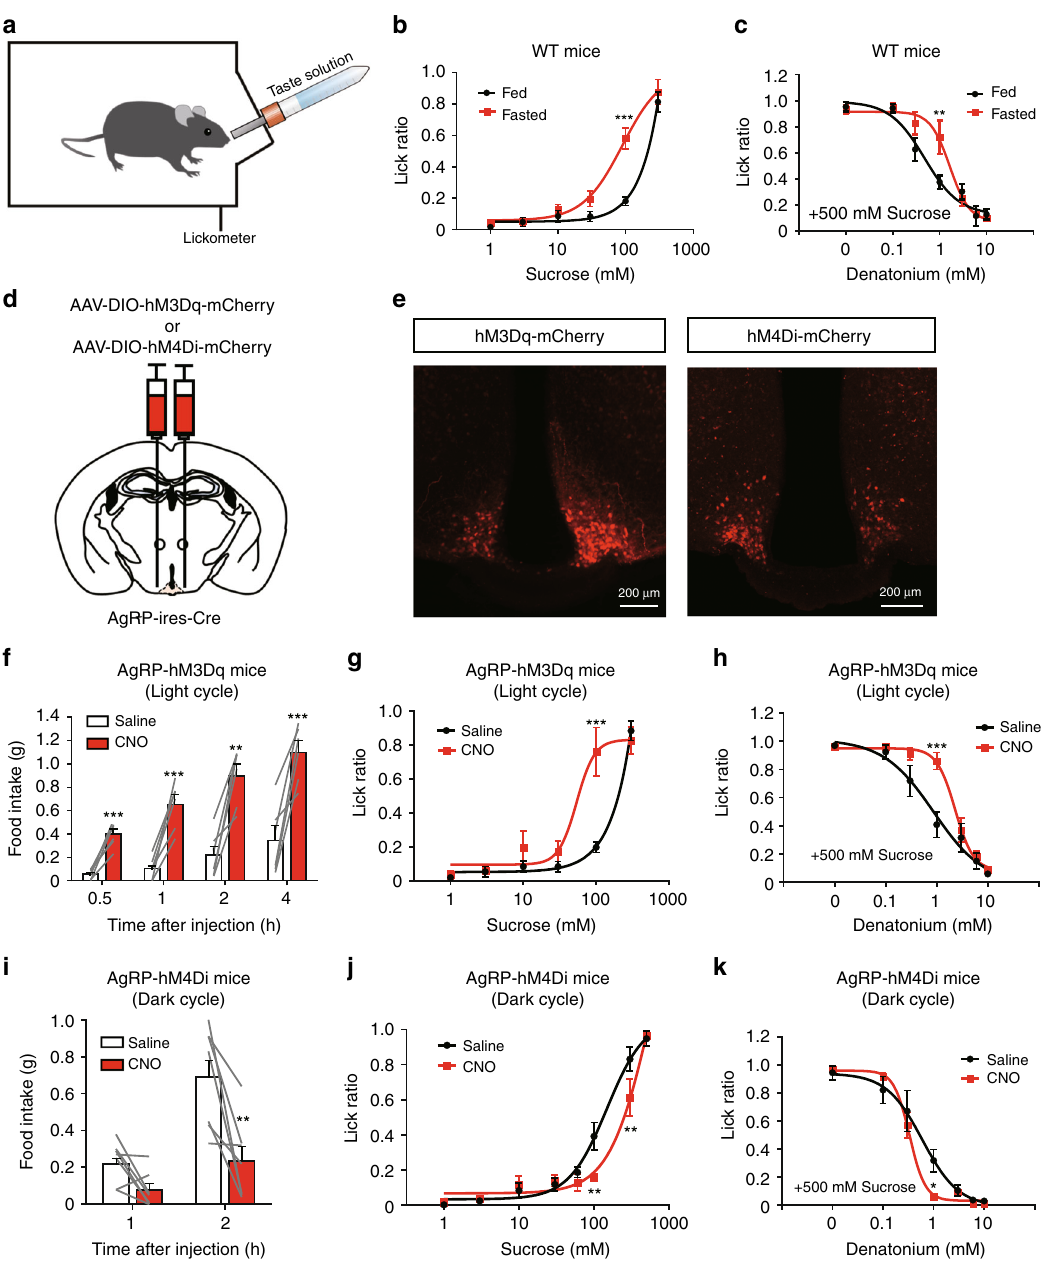
Fig. 1 Chemogenetic activation of AgRP neurons induces changes in taste preference. a Schematic image of the brief access taste test. The number of licks is measured during 10 s from the fi rst lick. b , c Sweet ( b ) or bitter ( c ) taste preferences in fed or fasted mice. Sucrose or denatonium – sucrose solutions were presented to fed or 23-h-fasted C57BL/6J WT mice. n = 6, F = 17.81, and P = 9.4 × 10 – 5 in b and n = 6, F = 4.14, and P = 0.045 in c , two-way ANOVA with Bonferroni post hoc test. d Bilateral injection of AAV encoding Cre-dependent hM3Dq-mCherry or hM4Di-mCherry into the arcuate nucleus (ARC) of AgRP-ires-Cre mouse. e Representative image showing hM3Dq-mCherry-expressing AgRP neurons (left) in the AgRP-hM3Dq mouse and hM4Di- mCherry-expressing AgRP neurons (right) in the AgRP-hM4Di mouse. f Chemogenetic activation of AgRP neurons led to acute food intake in AgRP- hM3Dq mice during the light period. n = 6, paired Student ’ s t test. g , h Brief access taste tests for sweet ( g ) or bitter ( h ) measured in AgRP-hM3Dq mice treated with saline or CNO (1.0 mg/kg i.p.) during the light cycle. n = 6, F = 8.783, and P = 0.0045 in g and n = 6, F = 7.929, and P = 0.0064 in h , two- way ANOVA with Bonferroni post hoc test. i Chemogenetic inhibition of AgRP neurons led to a reduction of food intake in AgRP-hM4Di mice during